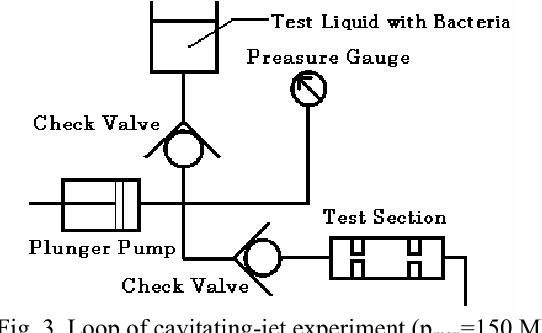
Fig. 3. Loop of cavitating-jet experiment (p